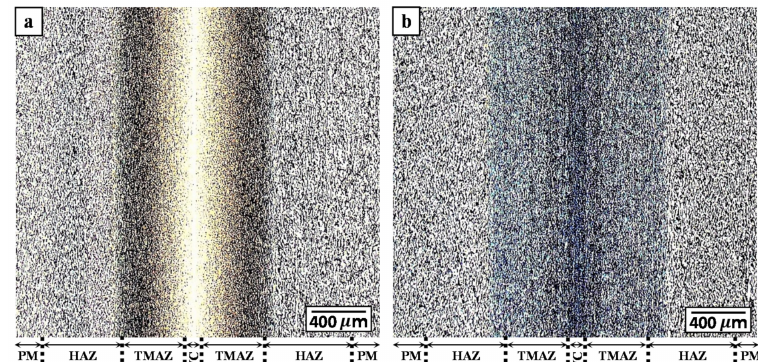
Figure 4. Optical microstructures of the ( a ) AWed and ( b ) SRAed